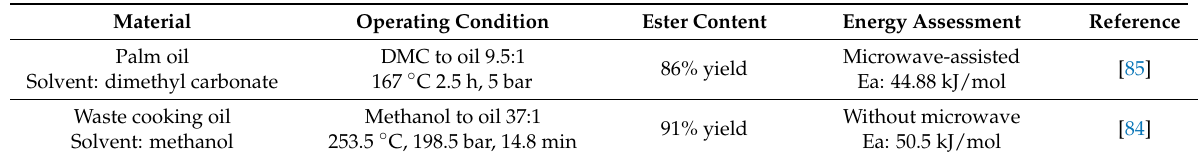
Table 5. Transesterification of triglycerides from different sources via supercritical/subcritical solvent with or without microwave